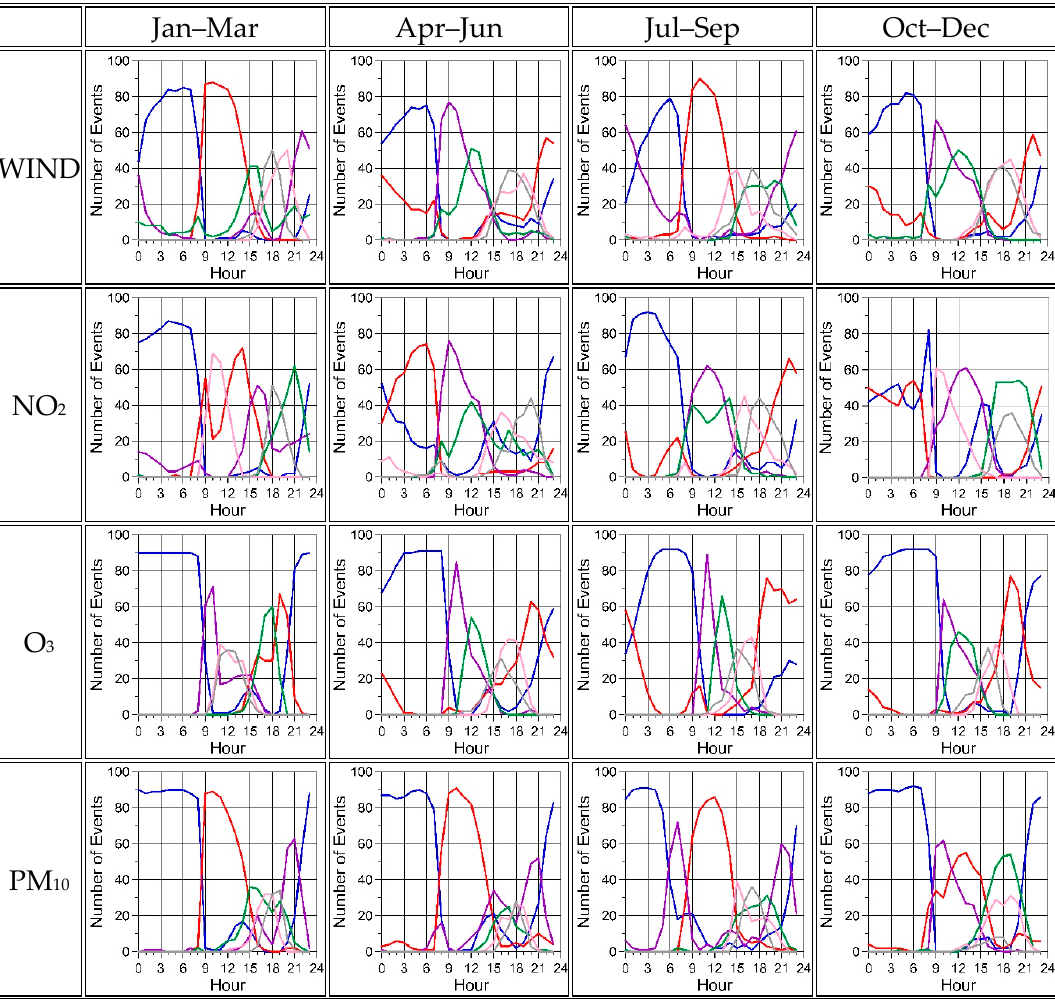
Figure 6. Percentage reduction ( δ ) of the total within-cluster sum of squares, relative to its previous value, as a function of the number of clusters. Here, for the clustering of the winter wind data objects, we observe that from 6 clusters on, the reduction δ is less than 10% each unit step in the increase of δ≤ ≤ the number of clusters: 0% 10%